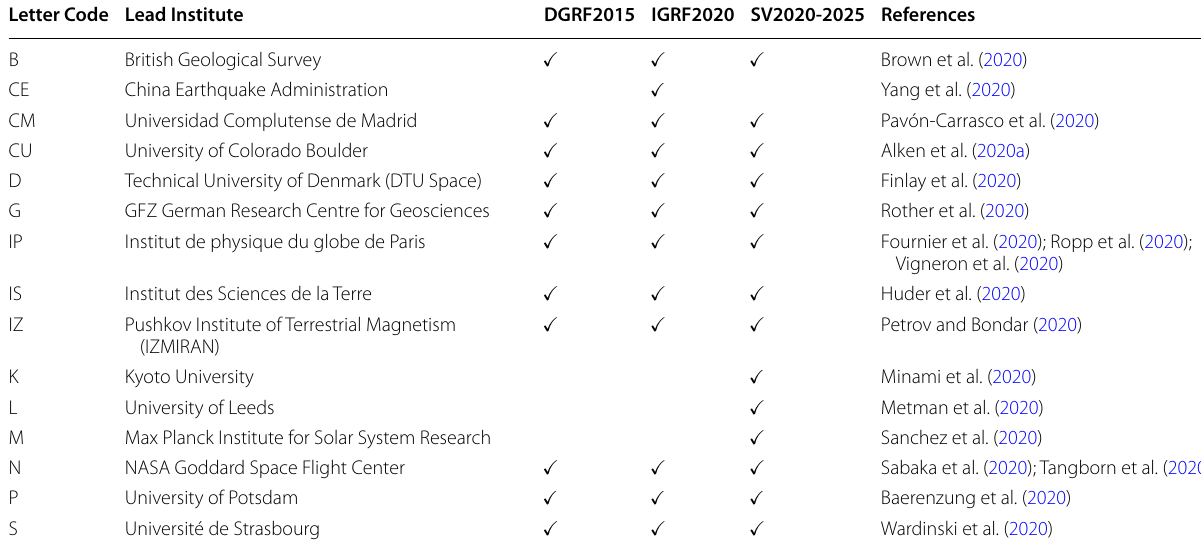
Table 1 Teams who submitted IGRF-13 candidate